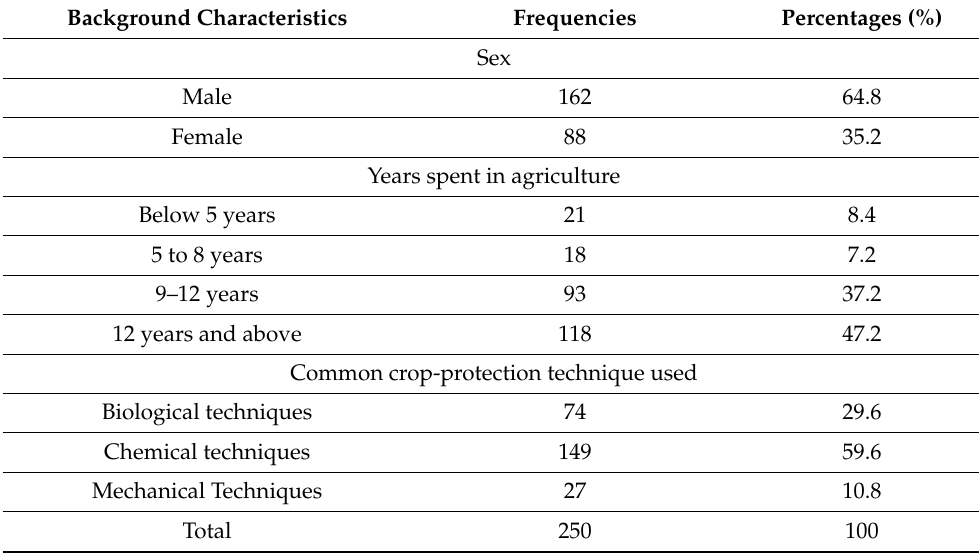
Table 3. Showing background characteristics of the